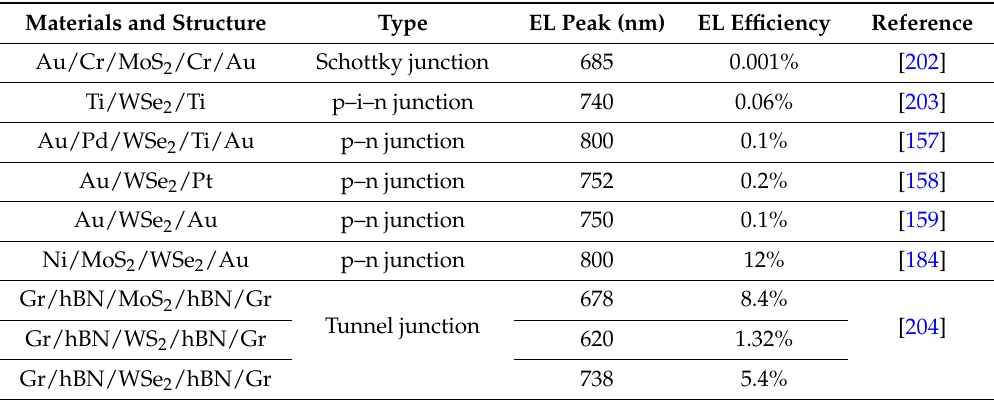
Table 5. Performance of light-emitting diodes (LEDs) with various transition metal dichalcogenide (TMDC) structures.